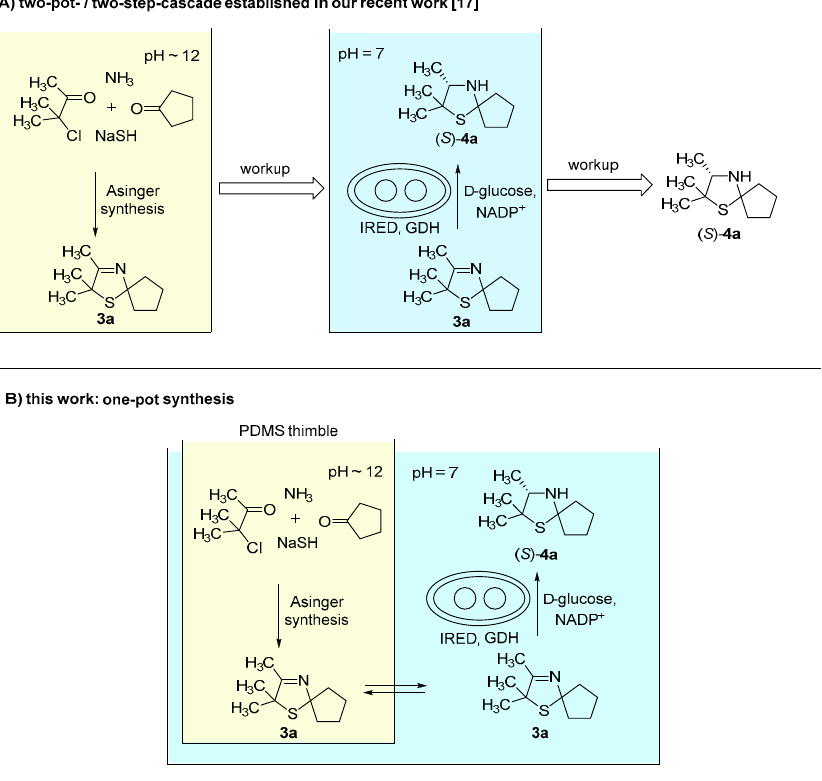
Figure 1. ( A ) Concept of our recent work: Synthesis of 3 ‐ thiazolidines ( 4a ) in a two ‐ pot ‐ /two ‐